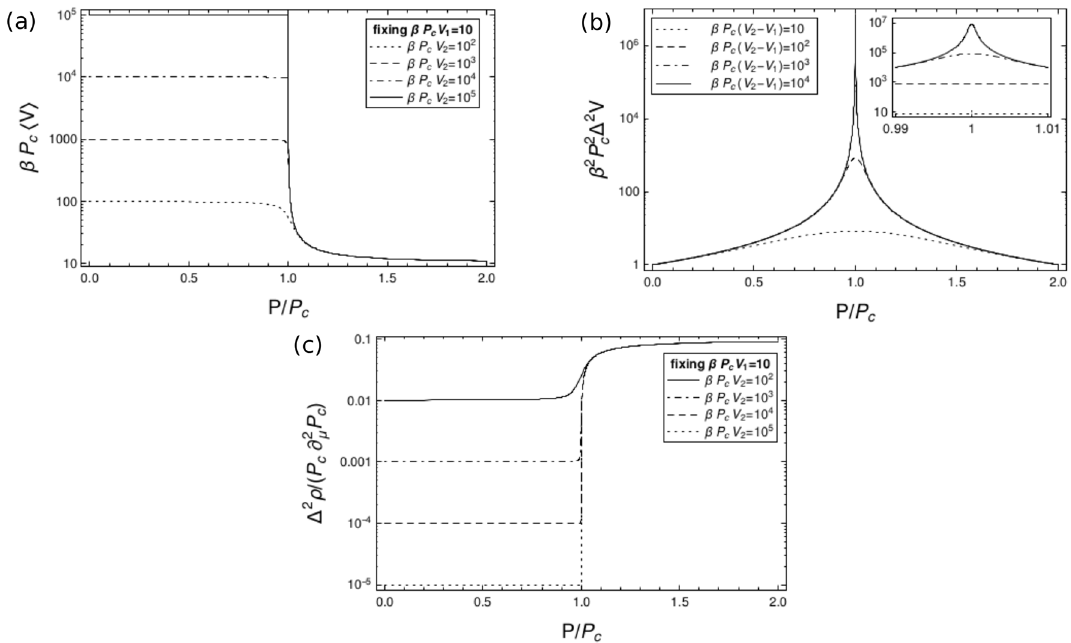
Figure 1. Semi-log plot of the rescaled average volume β P c (cid:31) V (cid:30) , the rescaled volume fluctuations β and the rescaled density fluctuations � β P c V 1 = 10 has been set in the plot of β P c (cid:31) V (cid:30) and �